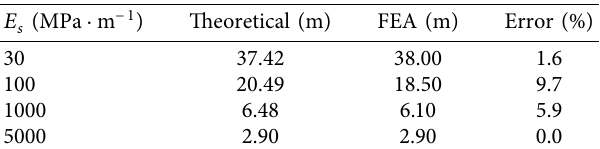
Figure 10: The interfacial tangential stress and displacement on the track slab. (a) Development of interfacial tangential stress. (b) Development of interfacial tangential displacement. Table 1: Comparison of the theoretical and simulated L various E s .